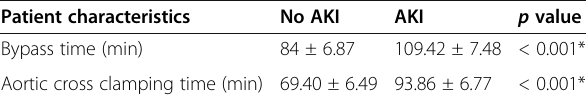
Table 2 Comparison of aortic and cross clamping time in both